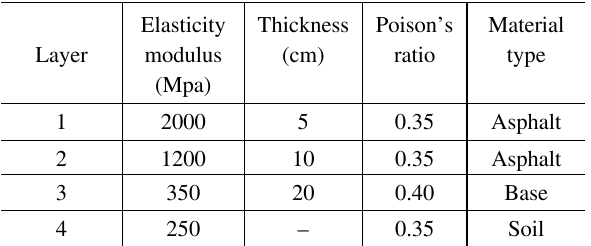
Table 1 . Geometric and material property of pavement structure